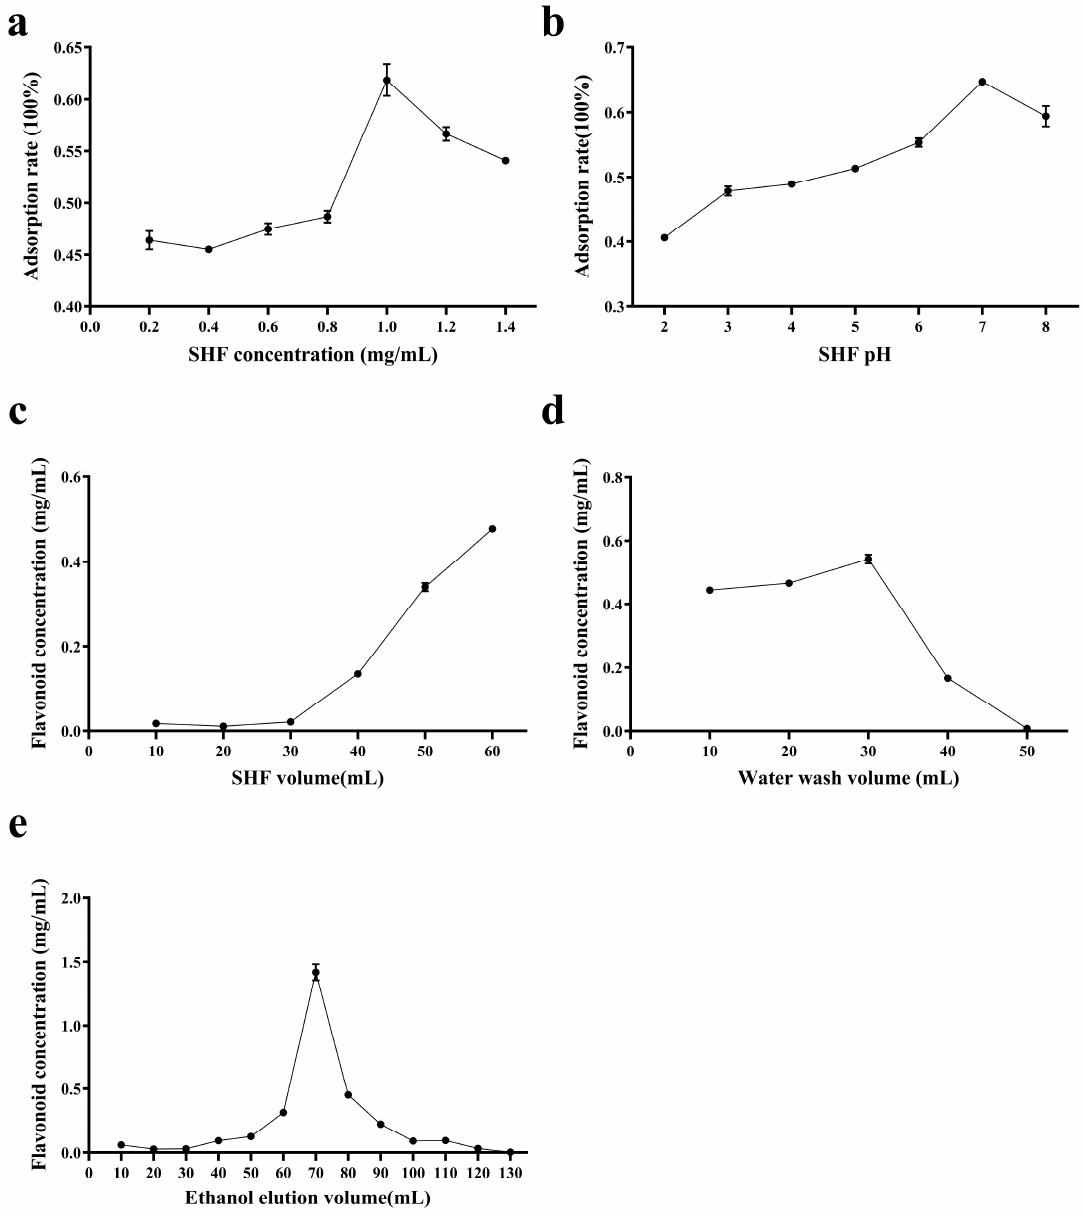
Figure 3. The effects of various factors on SHF purification: ( a ) SHF concentration; ( b ) SHF pH; ( c ) SHF volume; ( d ) water wash volume; and ( e ) ethanol elution volume.